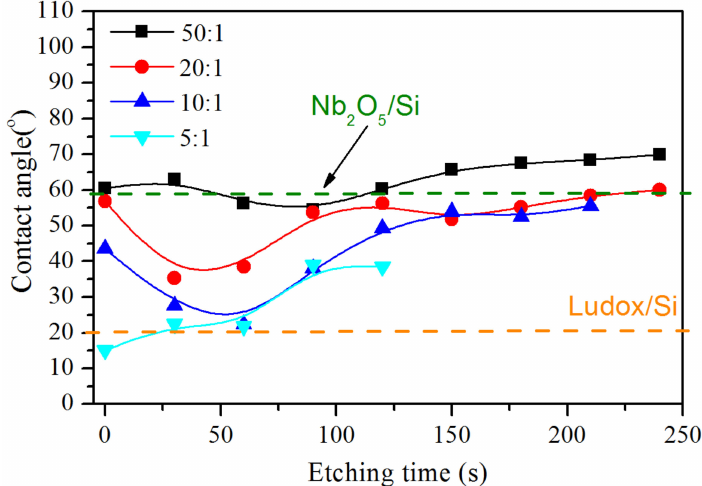
Figure 7. Water contact angles as a function of etching time of hard-templated porous Nb 2 O 5 films obtained by liquid phase mixing of Nb sol and silica colloids in different volume ratios indicated in the figure. Water contact angles of pure Ludox ® and niobia films are represented by the two dashed horizontal